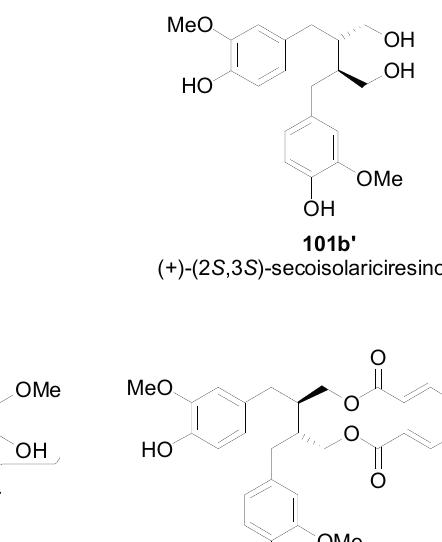
Figure 3. The structures of ( − )- and (+)-secoisolariciresinol, hanultarin ( 105 ) and 1,4- O -diferuloyl-secoisolariciresinol ( 106 ).